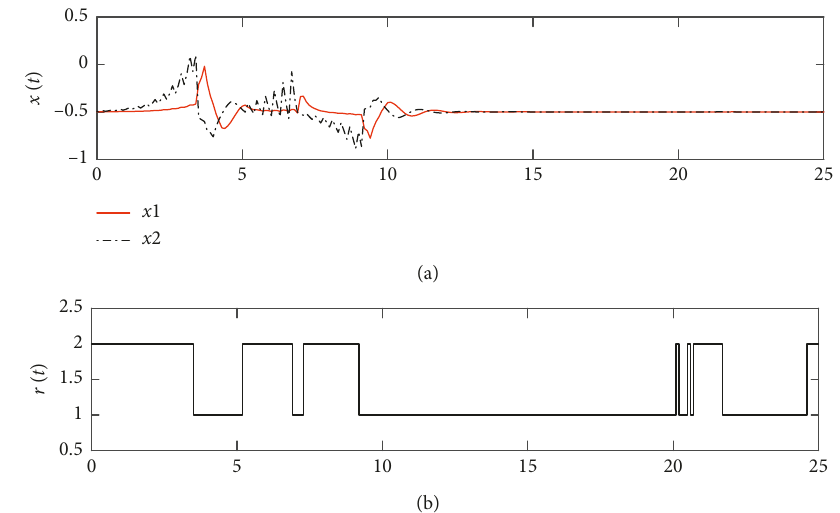
Figure 1: State trajectory x ( t ) and semi-Markovian chain r ( t ) of the networked control system containing actuator faults and time-varying delay.